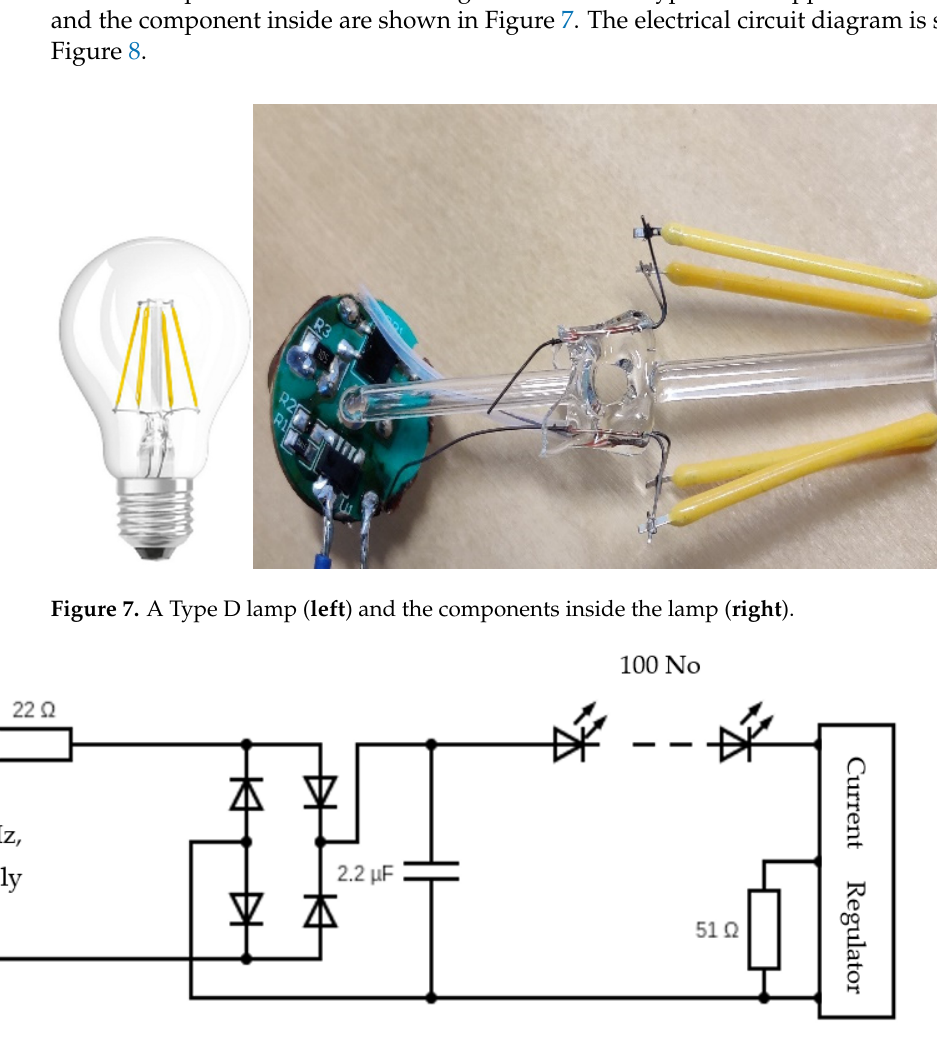
Figure 8. Simplified circuit diagram of Type D lamps.